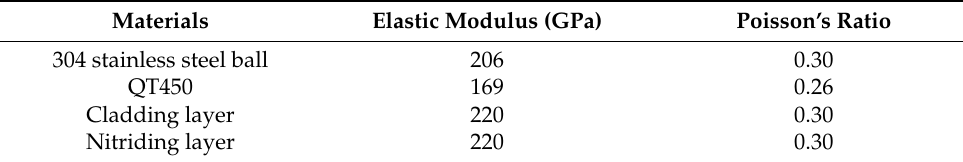
Table 5. Friction coefficient at different